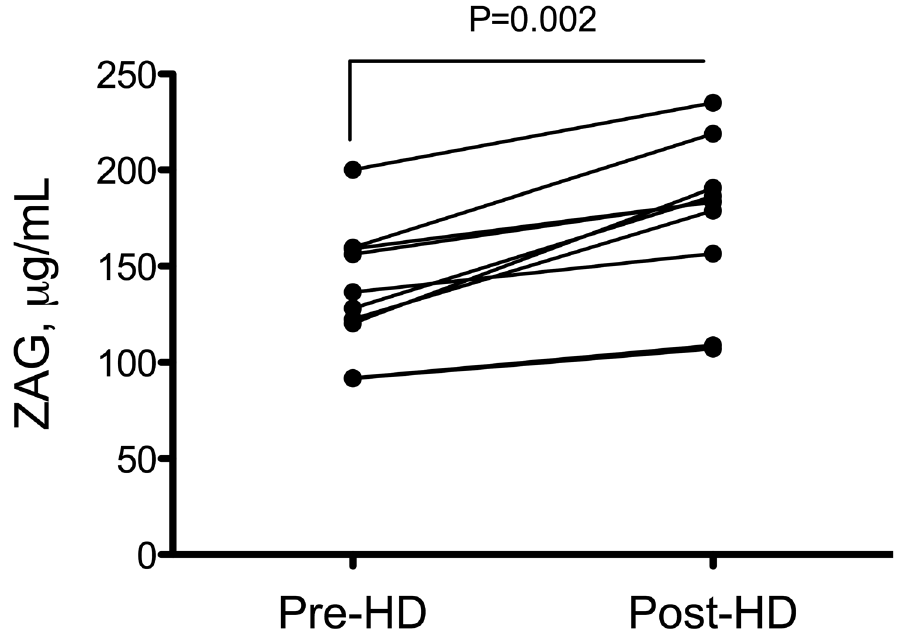
Figure 2. Plasma ZAG concentration increases during hemodialysis session. ZAG concentration was quantified by enzyme immunoassay before and after an hemodialysis session in ESRD patients (N=8). ZAG concentrations were corrected for hemoconcentration as described in methods. Differences between pre and post dialysis concentrations were considered significant at the P , 0.05 level (Wilcoxon test for paired samples). Abbreviation: HD, hemodialysis. doi:10.1371/journal.pone.0103475.g002 blockers (33.3%) and 30 on antidiabetic drugs (31.5%, amongst Plasma ZAG concentration increases in ESRD patients which 24 used insulin and 6 oral antidiabetics). The main clinical, Surprisingly, plasma ZAG concentration did not gradually anthropometric and biochemical characteristics of the cohort are increase from CKD stage 1 to CKD stage 4 when compared to summarized in Table 1 and dialysis adequacy is described in non-CKD patients ( Figure 1 ). Plasma ZAG concentration was Table 2 . As expected, eGFR (estimated by CKD EPI, P , 0.001), however 2.3-fold higher in CKD 5 (ESRD) patients as compared plasma creatinine (P , 0.001) and urea (P , 0.001) were different with non-CKD patients or CKD stage 1 to 4 patients (Kruskall & between groups. Wallis test, P , 0.005). The plasma ZAG concentration was 41.5